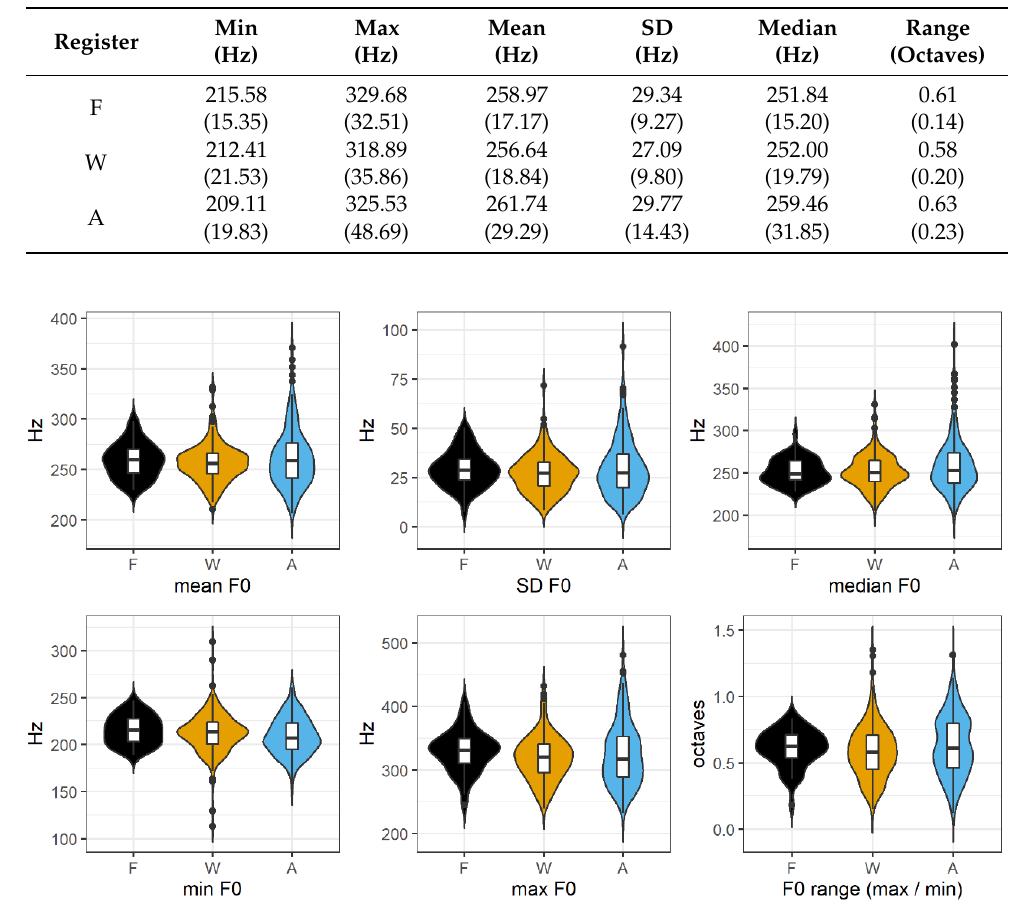
Figure 3. Median and interquartile range and frequency distribution of values across turns by register code for mean, SD, median, min and max values of F0, and F0 range (max/min) in octaves.